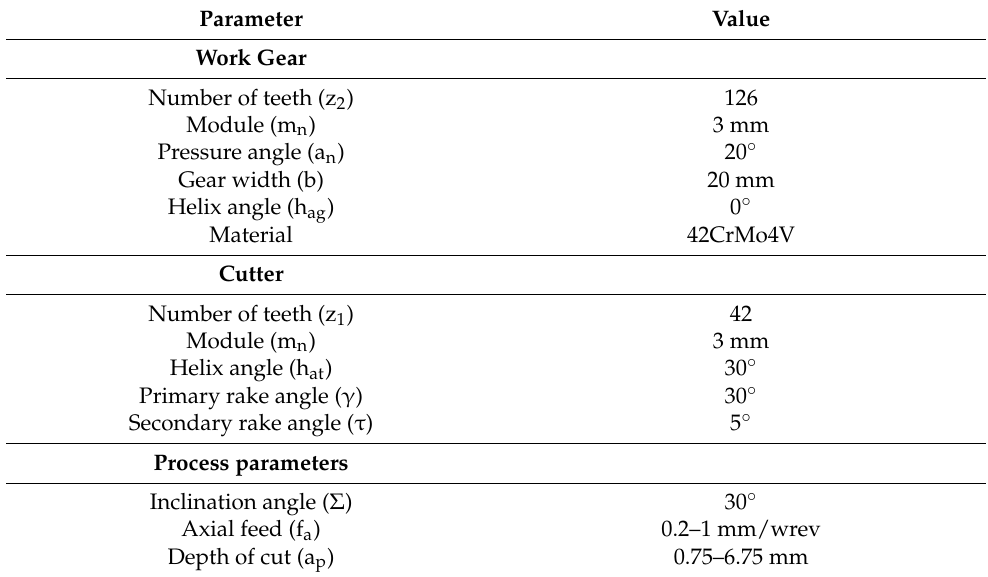
Table 1. Case study parameters.